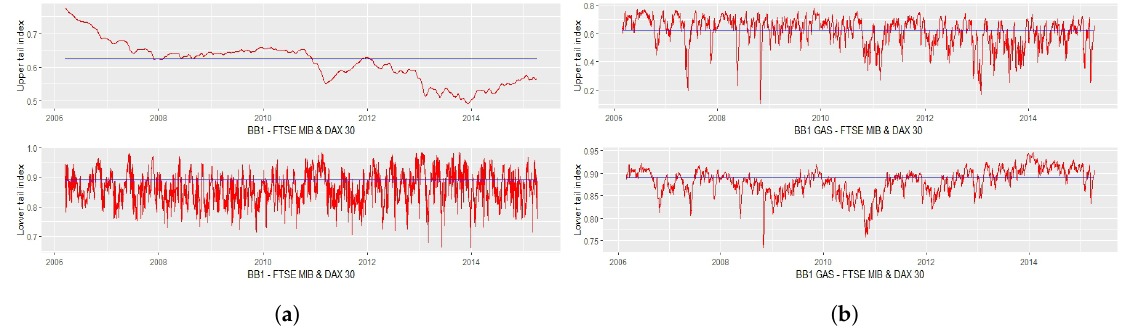
Figure 1. Upper and lower tail indices of FTSE MIB–DAX 30. ( a ) BB1 with dynamic Equation (6); ( b ) BB1 copula with dynamic Equation (7).